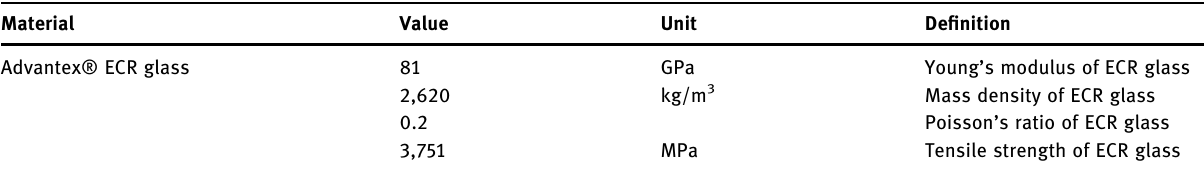
Table 8: Mechanical properties of E - glass fi ber used for CNTFPC rebar